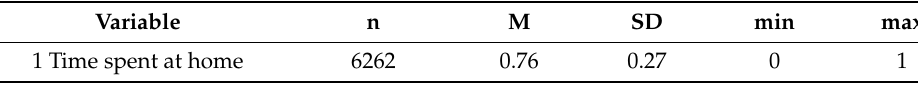
Table 1. Summary statement on the time spent at home.